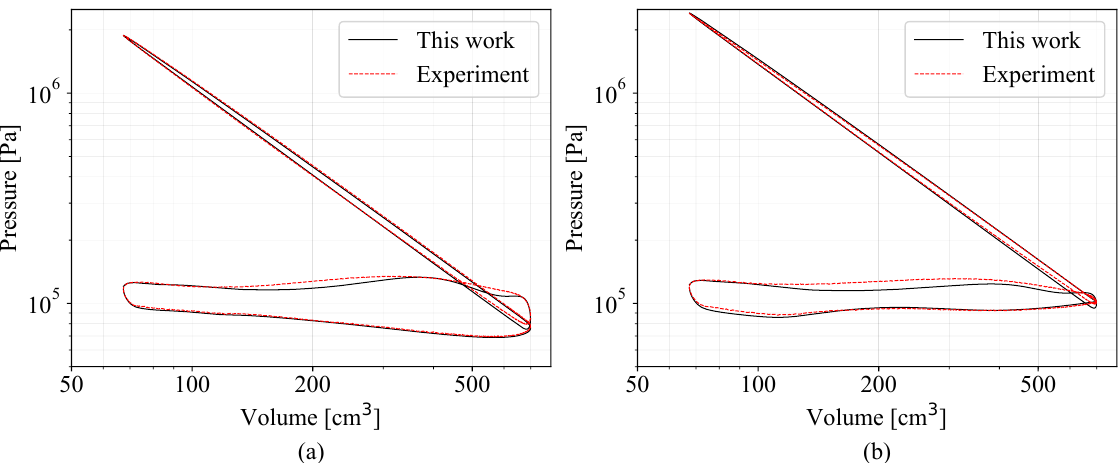
Figure 12. Experimental and numerical pressure-volume diagrams for both throttle valve positions: ( a ) throttle at 35 ◦ ; ( b ) throttle at 80 ◦